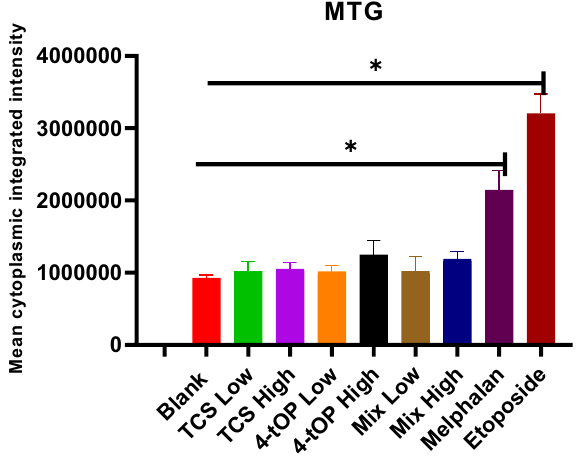
Figure 10. MTG-Mitotracker green staining for the determination of the effect of the test substances on mitochondrial mass. p values * = 0.0001, n = 4.